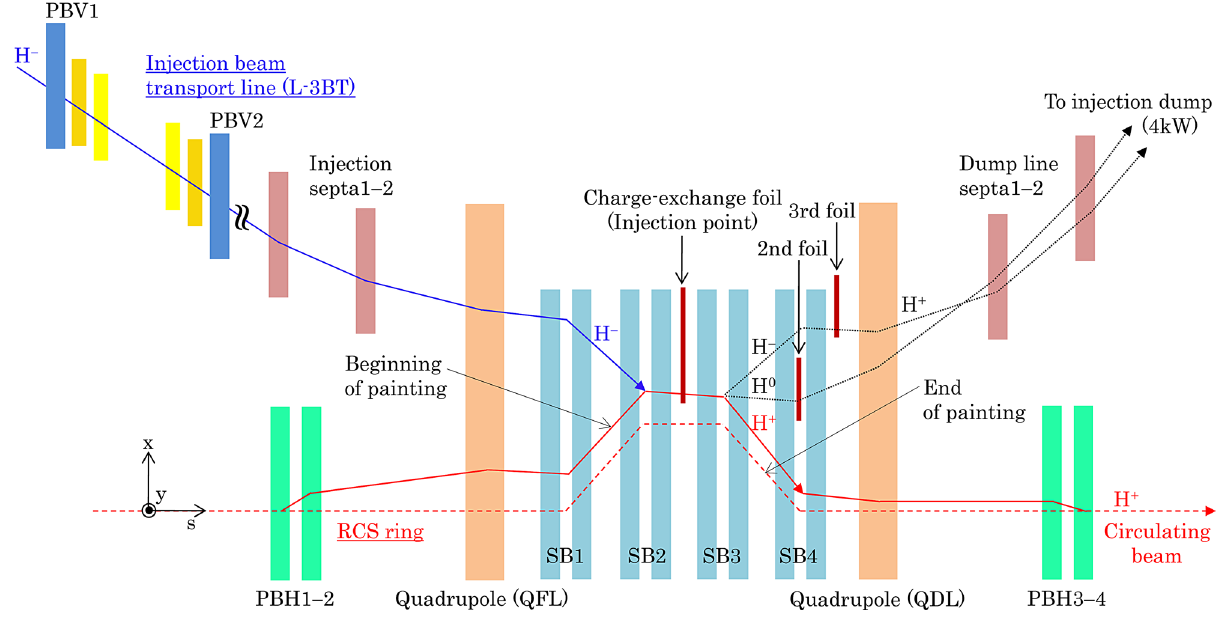
FIG. 2. Schematic view of the RCS injection section.